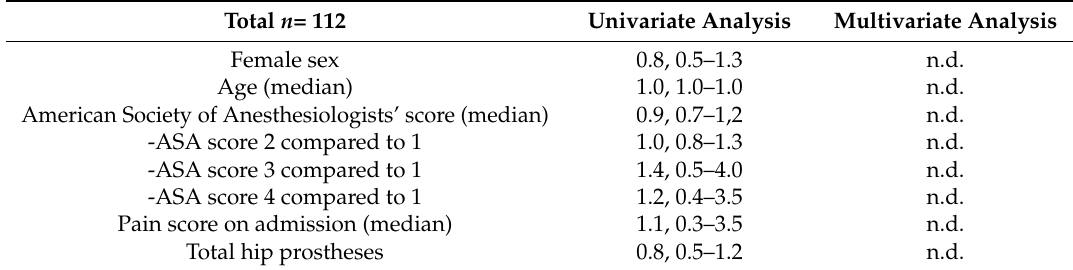
Table 3. Univariate and multivariate analyses of factors potentially related to remission of retained infected arthroplasties (results expressed as hazard ratios with 95% confidence